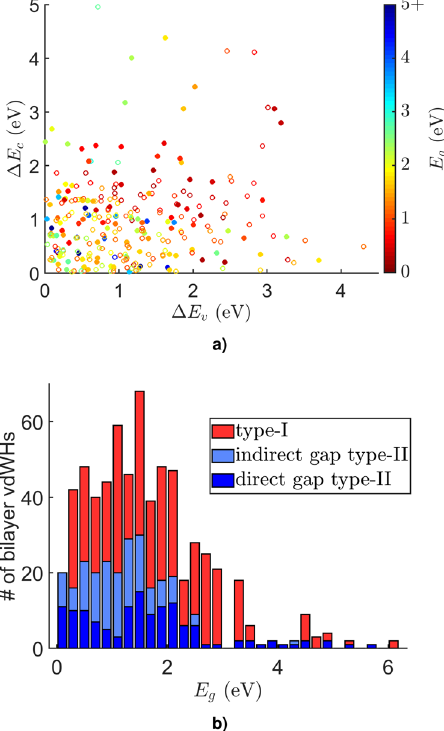
Fig. 5 Band information for the 292 type-II bi-layer vdWHs constructed with the non-interacting model. a Band gaps and band offsets. The band gaps are shown as a color code, with the scale reported on the right-hand side. Solid symbols are for direct- gap vdWHs, while the hollow ones are for indirect. b The distribution of band gaps among 641 type-I and type-II vdWHs. The red portion of each bar represents number of type-I vdWHs, while the blue (sky blue) one indicates the number of type-II vdWHs with direct (indirect) band gap.